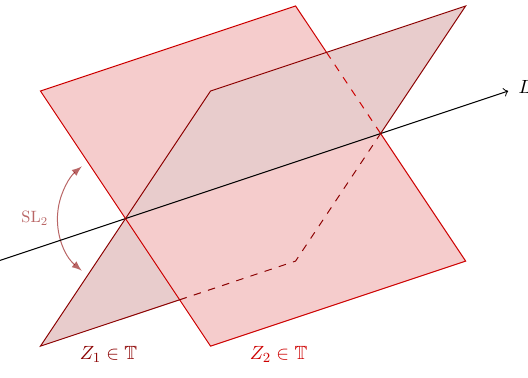
Figure 2 . Ambitwistor space in 6d parametrized by a pair of twistors Z a